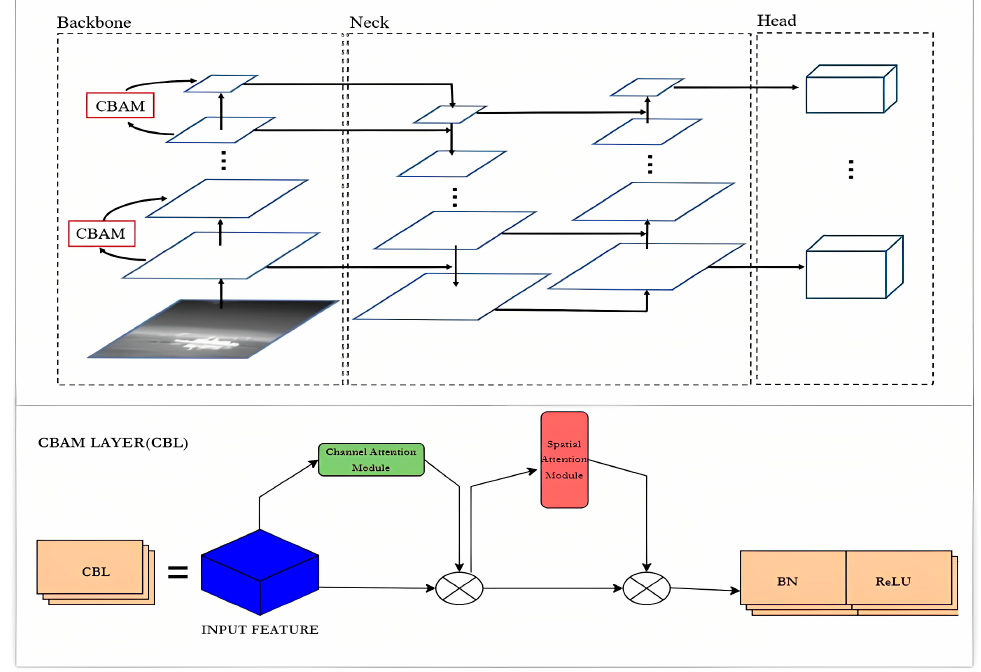
Figure 4. Modi fi ed Structure of YoloV5 with CBL . Figure 4. Modified Structure of YoloV5 with